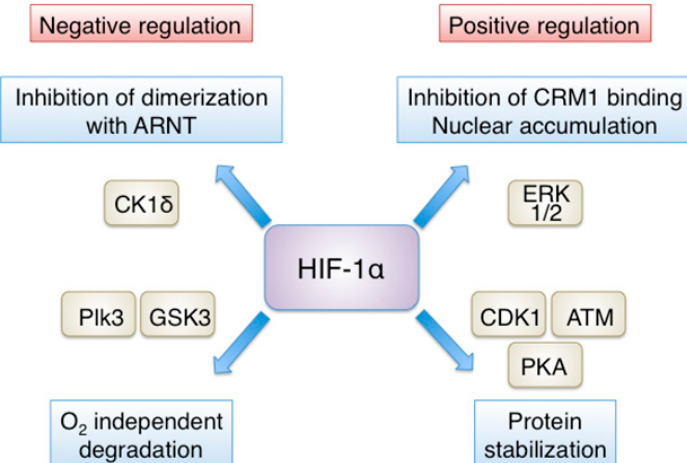
Figure 2. Positive and negative regulation of HIF-1 α by phosphorylation. Direct phosphorylation by several kinases is important for HIF-1 α regulation. Positive regulation: ERK1/2-dependent phosphorylation inhibits binding of the exportin CRM1 and promotes nuclear accumulation of HIF-1 α , while phosphorylation by ATM, CDK1 or PKA inhibits HIF-1 α degradation. Negative regulation: phosphorylation by casein CK1 δ impairs HIF-1 α association with ARNT and thus, decreases HIF-1 transcriptional activity, while phosphorylation by GSK3 or Plk3 results in VHL-independent degradation of HIF-1 α . See text for details and references.